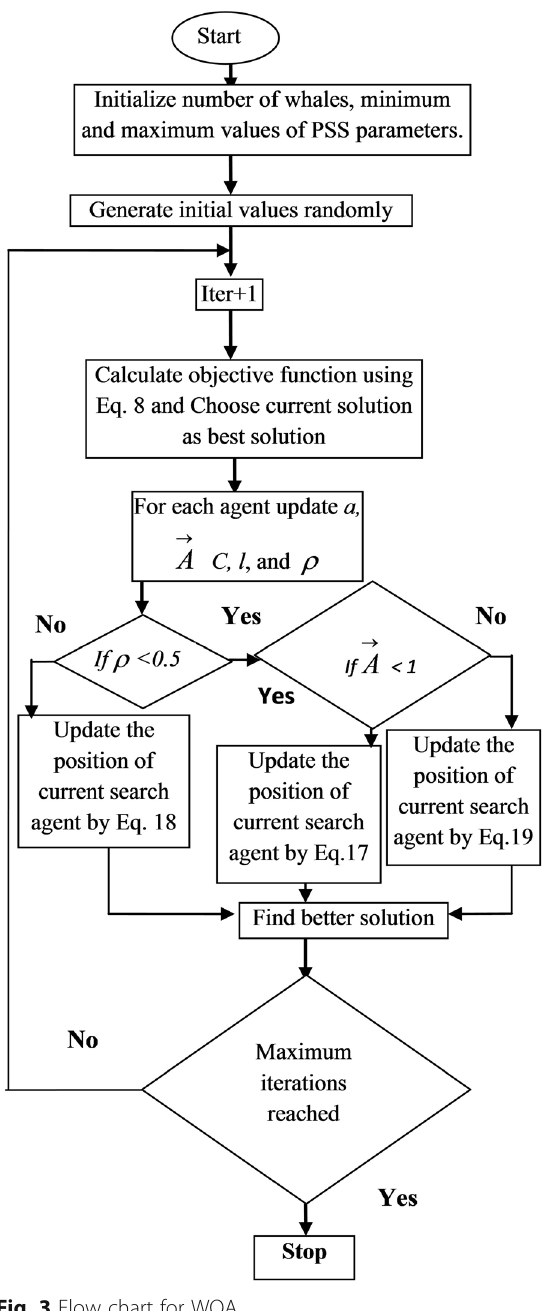
Fig. 3 Flow chart for WOA